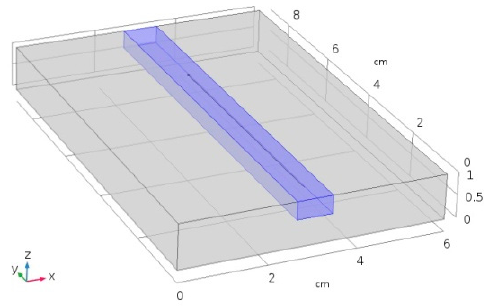
Figure 3. Domains of interest: central slot (blue domain, D 1 ), and remaining (grey domain, D 2 ).